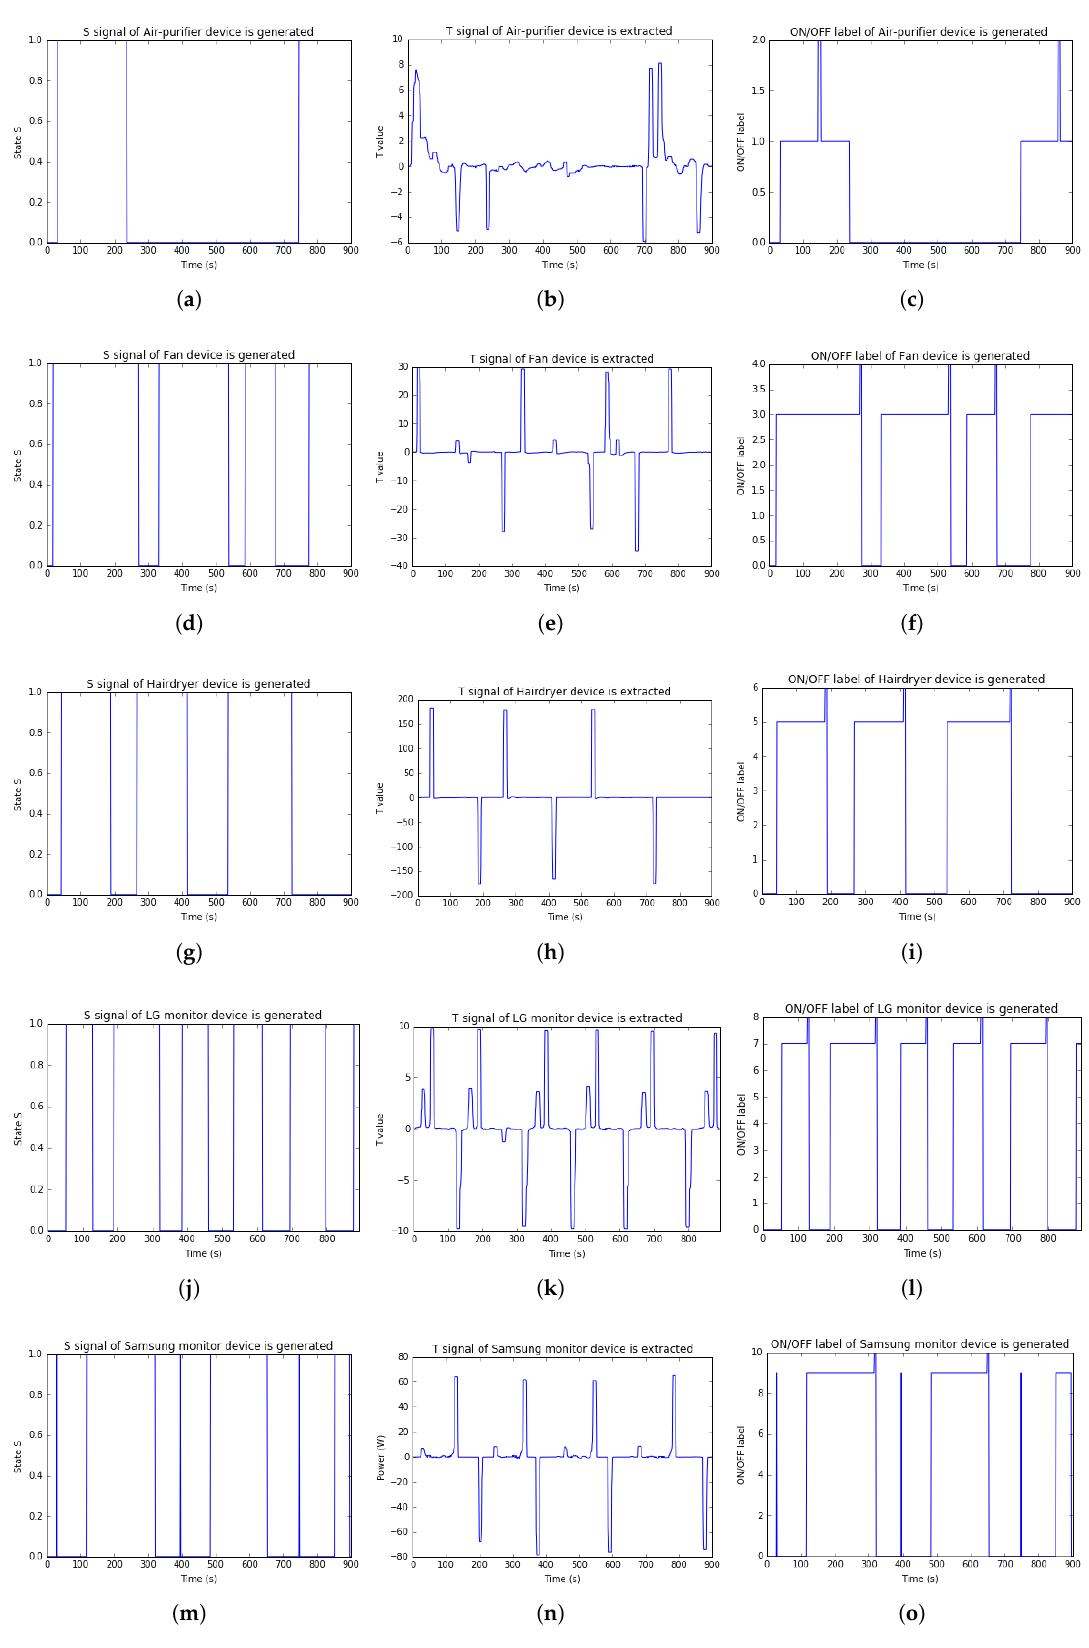
Figure 12. State S , T & ON/OFF label signals of 5 appliances: ( a – c ): Air-purifier device; ( d – f ): Fan device; ( g – i ): Hair Dryer device; ( j – l ): LG monitor device; ( m – o ): Samsung monitor